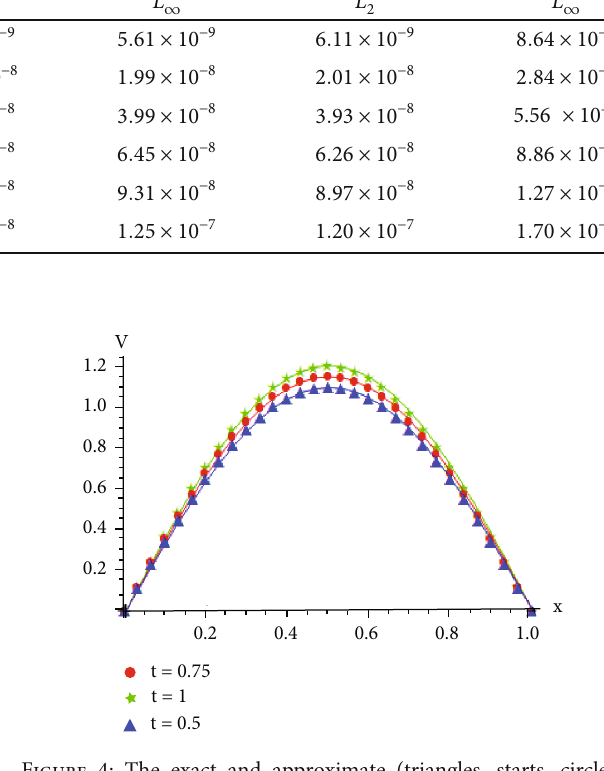
Figure 4: The exact and approximate (triangles, starts, circles) solutions for Example 6 at various times when h = 0 : 01